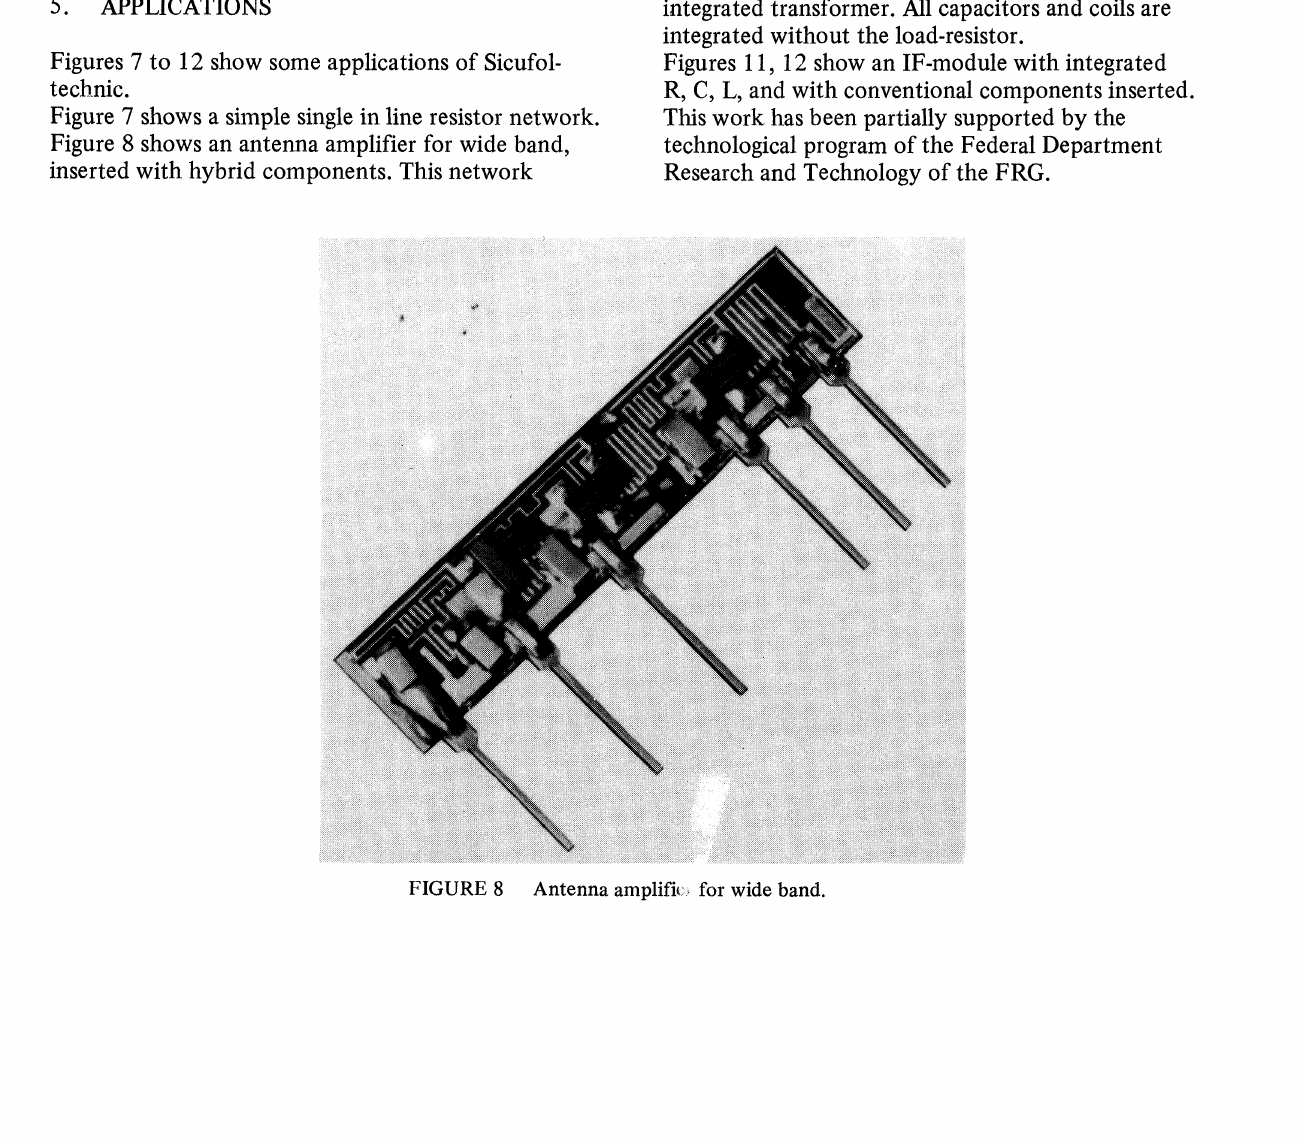
FIGURE 7 SIL-resistor network.